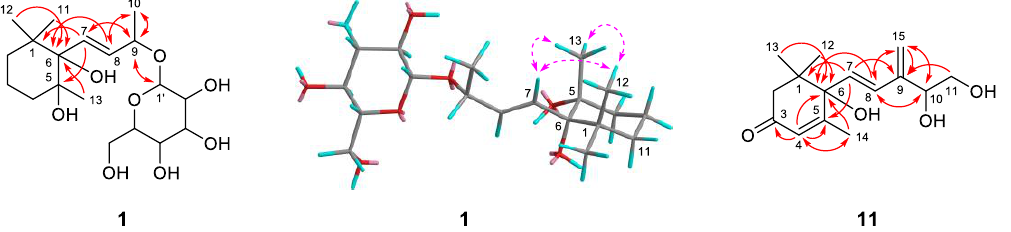
Figure 3. Key HMBC (plain) or NOESY (dashed) correlations of compounds 1 and 11.